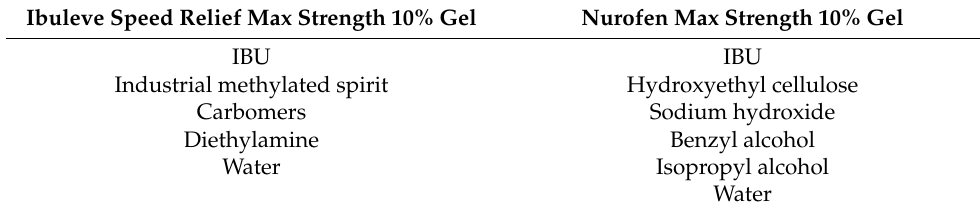
Table 1. Ingredients of the topical formulations, Ibuleve and